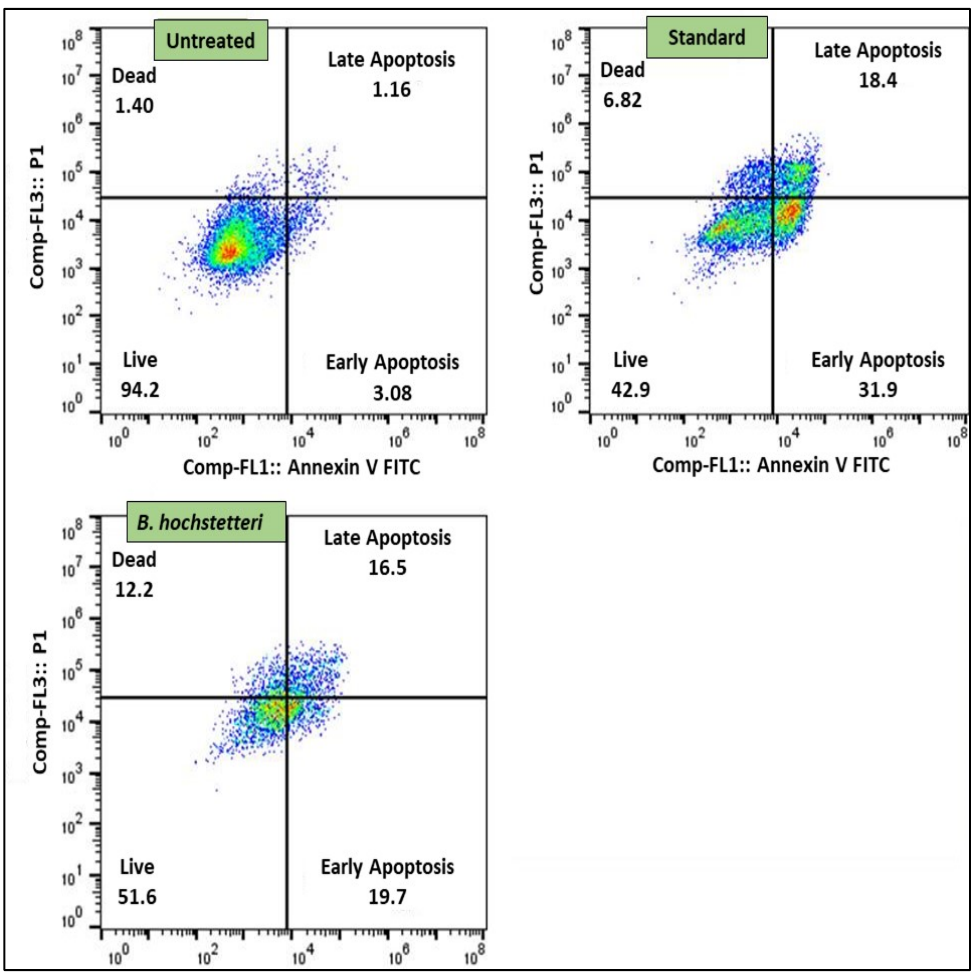
Figure 1. The methanol extract of B. hochstetteri induced early and late apoptosis in the lung cancer A549 cell line.